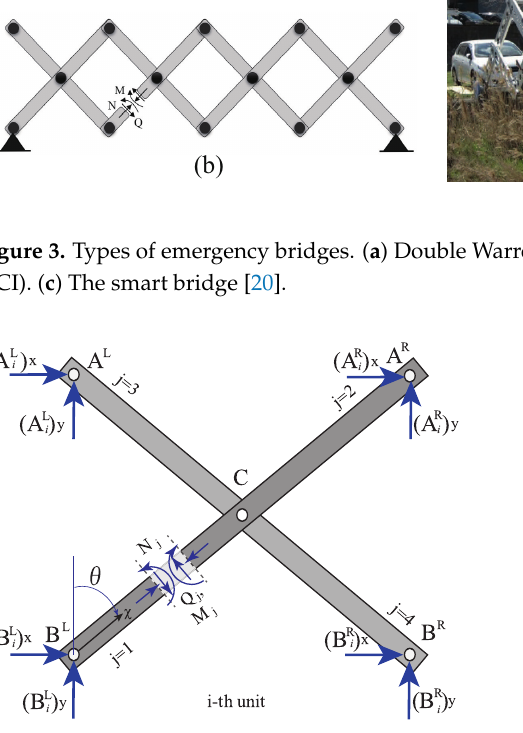
Figure 4. Definition of the coordinate system and sectional forces in a scissors unit structure.